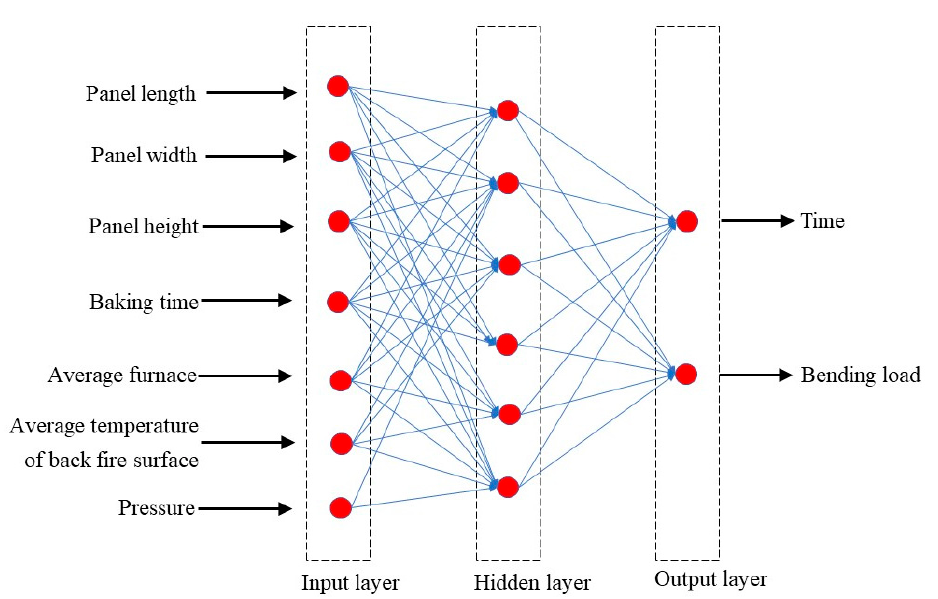
Figure 3. Application of the BP neural network in the thermal–mechanical coupling evaluation of substation panel performance.